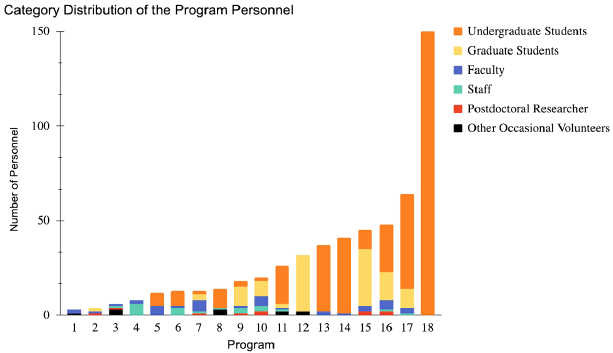
FIG. 4. Distribution of the programs ’ personnel based on their physics status. Program numbers are organized based on the ascending order of their number of